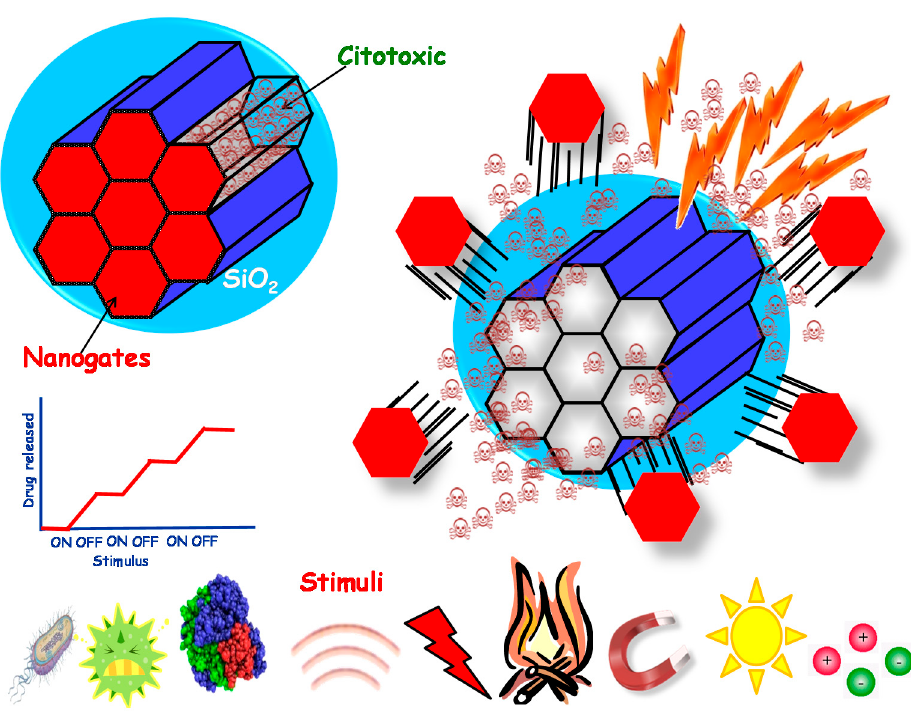
Figure 2. Stimuli-responsive nanoparticles where the drug release can be triggered through the application of many different stimuli.